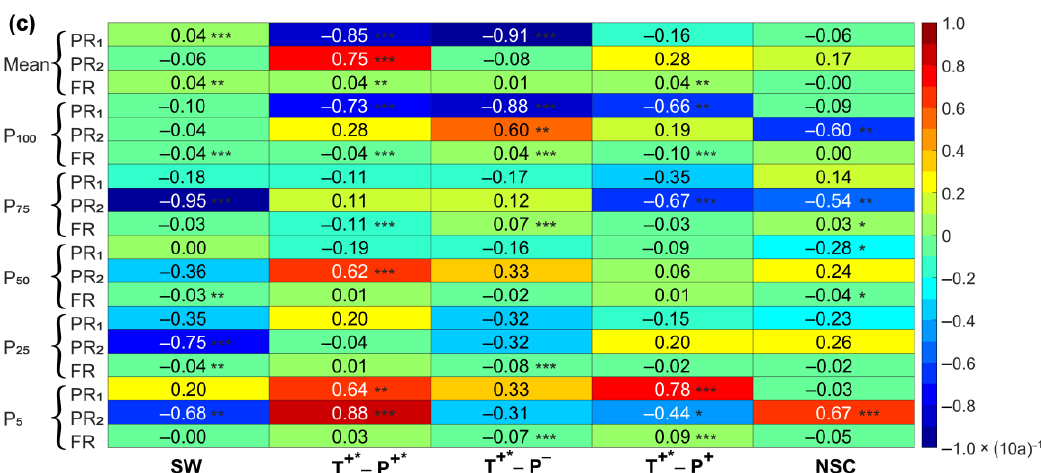
Figure 5. The variation tendency of the correlation coefficient between NDVI and temperature and precipitation in a 15-year period considering ( a ) the same period, ( b ) the annual, and ( c ) the interannual time lag. PR 1 and PR 2 represent the partial correlation coefficient between NDVI and temperature and precipitation, respectively, and FR represents the multiple correlation coefficient.